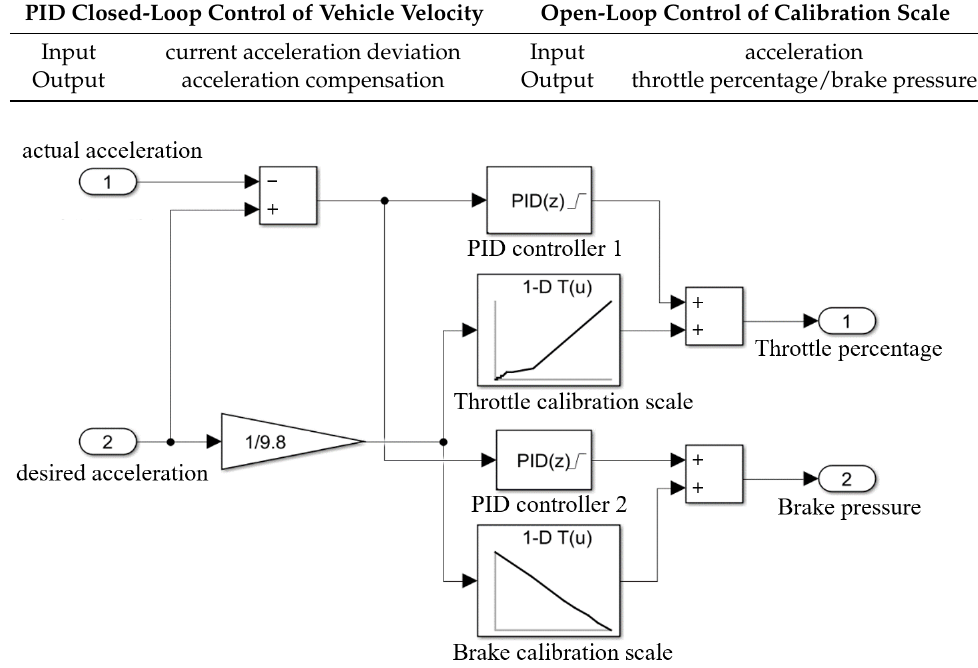
Figure 9. Longitudinal PID control model.